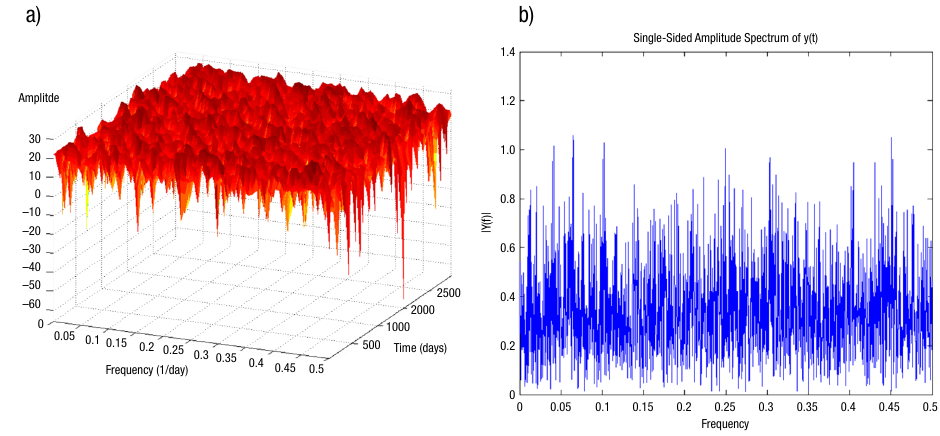
Fig. 8. White noise spectrogram (a), spectrum (b), source: own